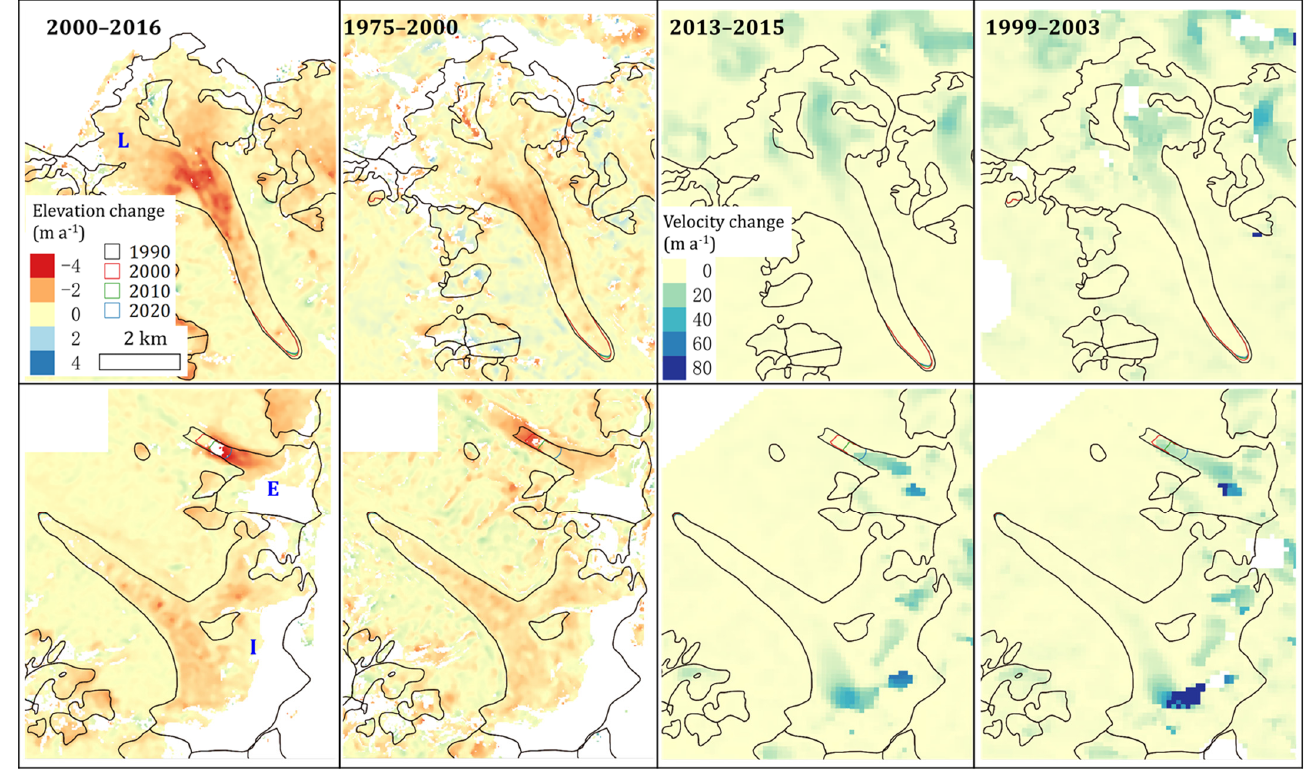
Figure 3. Comparisons of elevation change rates and velocities of three typical land- and lake-terminating glaciers (Glacier E, I, and L) on the east and west sides of the basin.